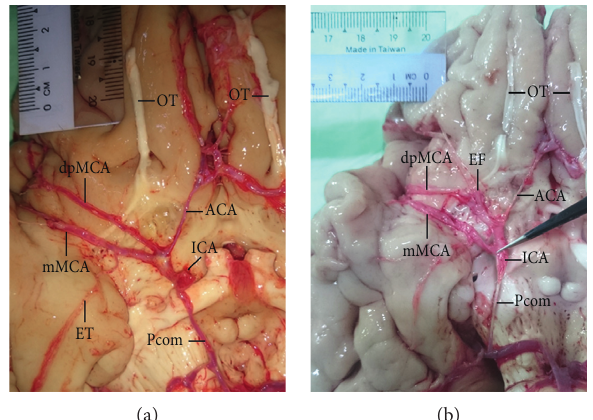
Figure 1: Double MCA consisting of the mMCA and the dpMCA arising from the distal part of the ICA and coexisting with hypoplasia of the anterior cerebral artery (ACA). (a) Atherosclerosis at the triple junction of the double MCA and hypoplastic ACA suggesting he- modynamic imbalance and representing a potential risk for aneurysm. (b) Origins of the dpMCA and mMCA a few millimeters apart in a location that is not associated with a high risk of hemodynamic disturbance. Early temporal (ET) and early frontal (EF) branches arising from the mMCA (a) and dpMCA (b), respectively, are shown. OT, olfactory tract; Pcom, posterior communicating artery.